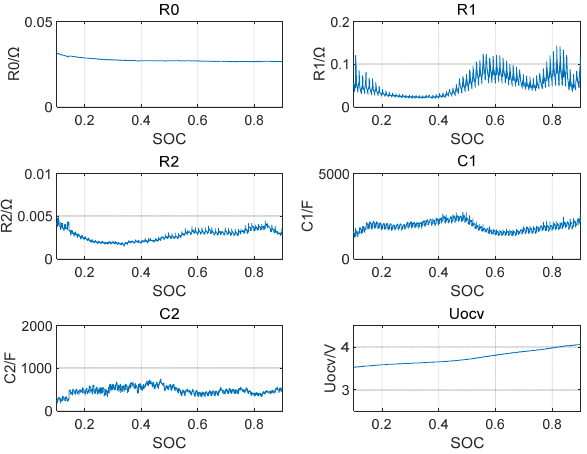
Figure 4. Battery parameter identification results.